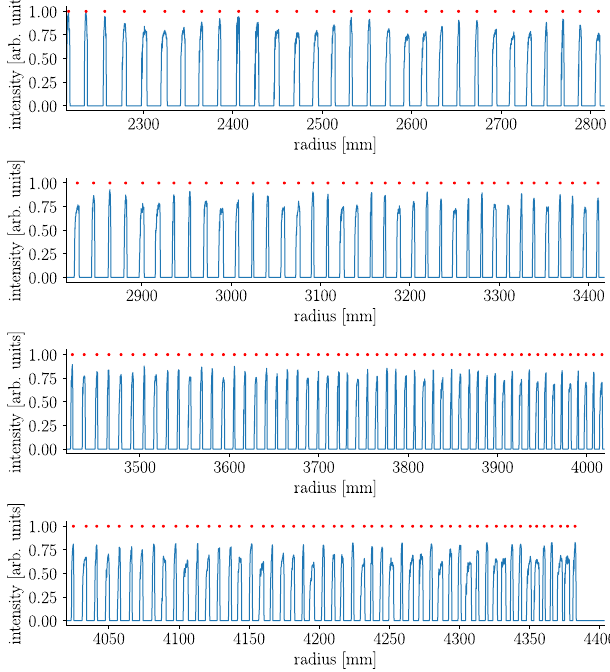
FIG. 4. Histogram of the probe RRL measurement. The intensity is normalized. The red dots mark detected peaks.